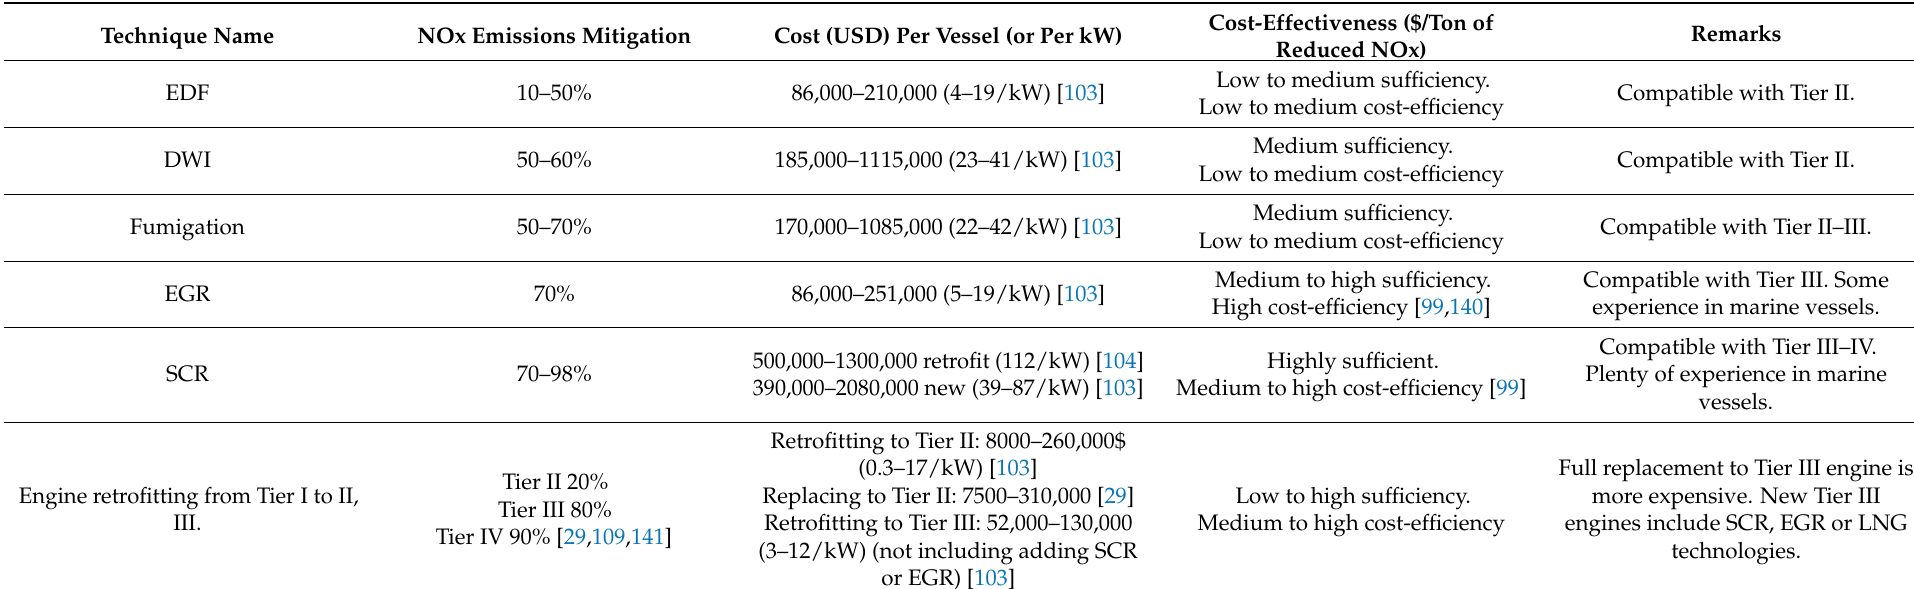
Table A35. NOx mitigation